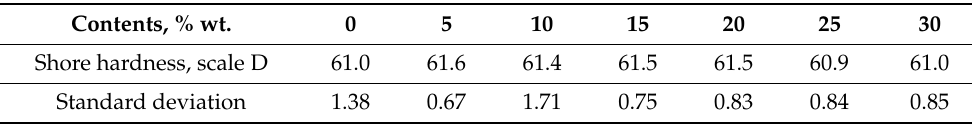
Table 8. Hardness depending on the content of the Crusil M20 filler. Contents, %